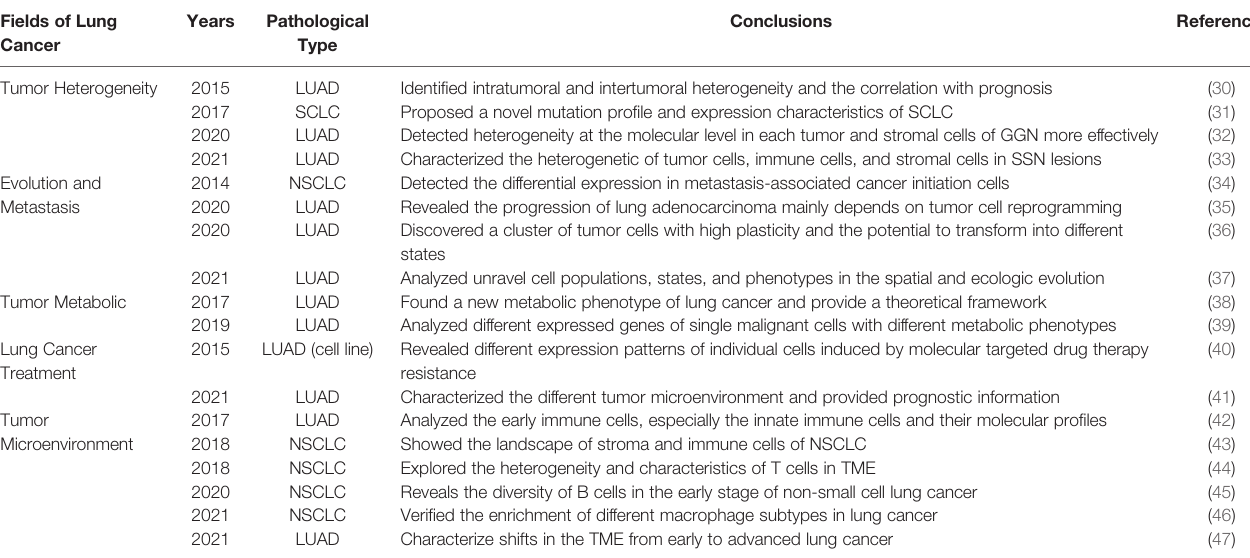
TABLE 1 | Important discoveries of single-cell technology in the evolution of early-stage lung cancer. Fields of Lung